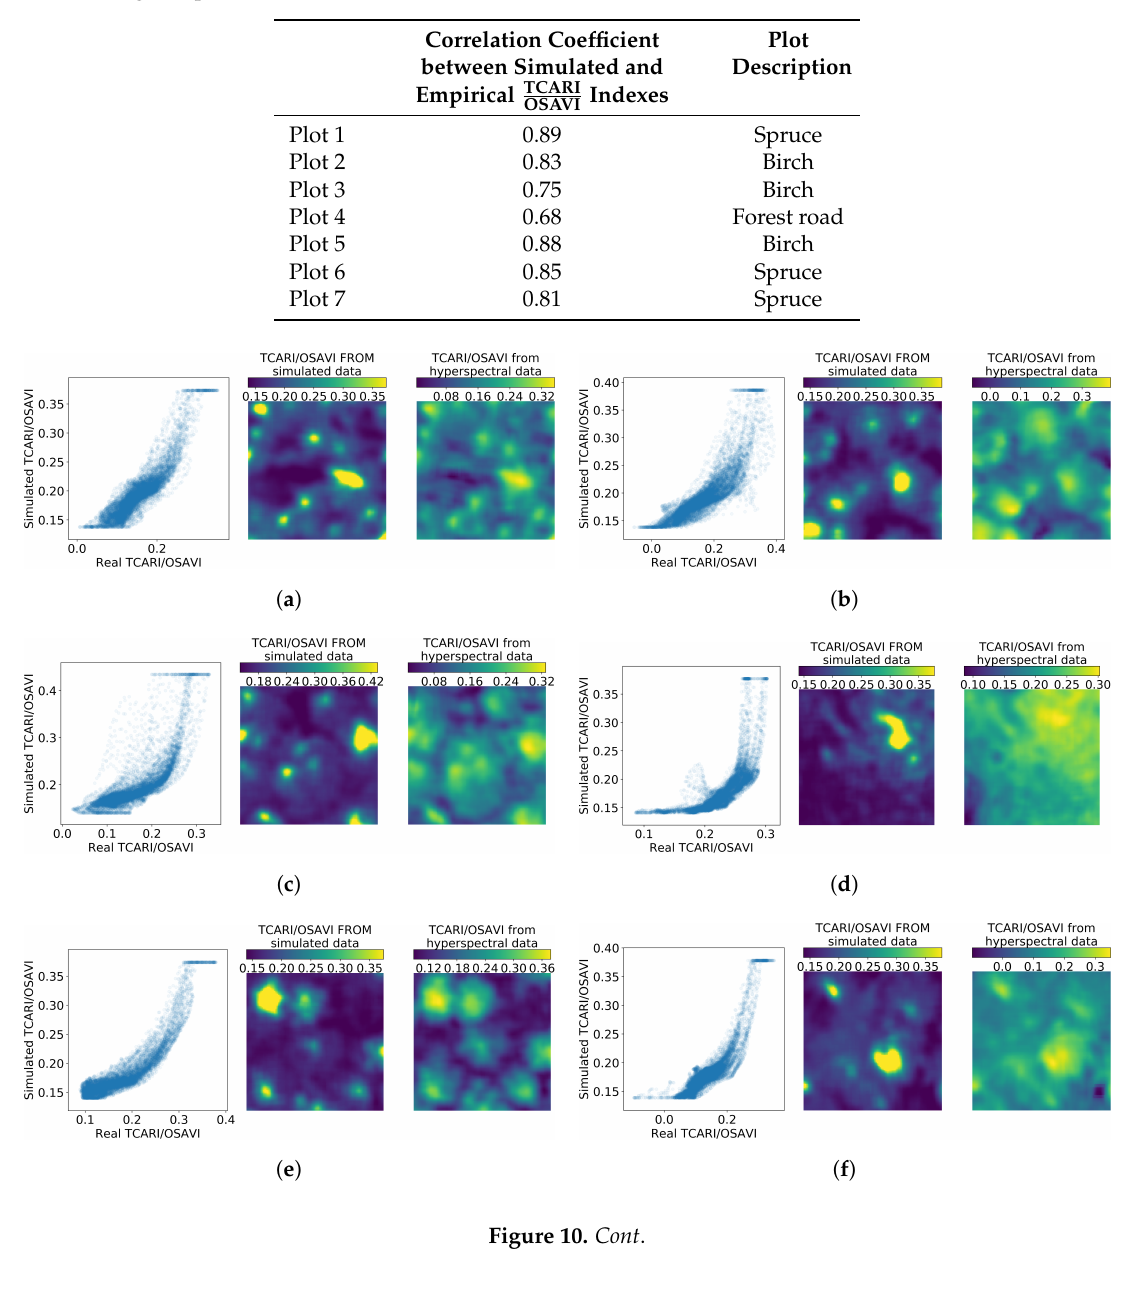
indexes in the seven OSAVI